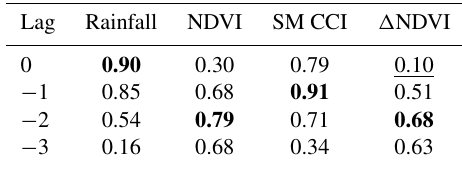
Table 3. Correlation coefficients of ancillary variables with GRACE TWS. The optimal time lag is indicated by bold correlations. The underlined correlations are not statistically